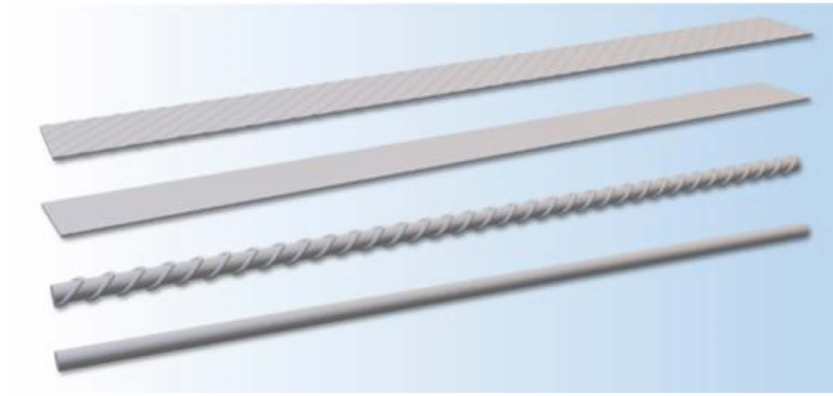
Figure 5. Three-dimensional schematic diagram of Fe-SMAs in different shapes. Table 3. The development history of Fe-Mn-Si alloys [22,86]. Alloys